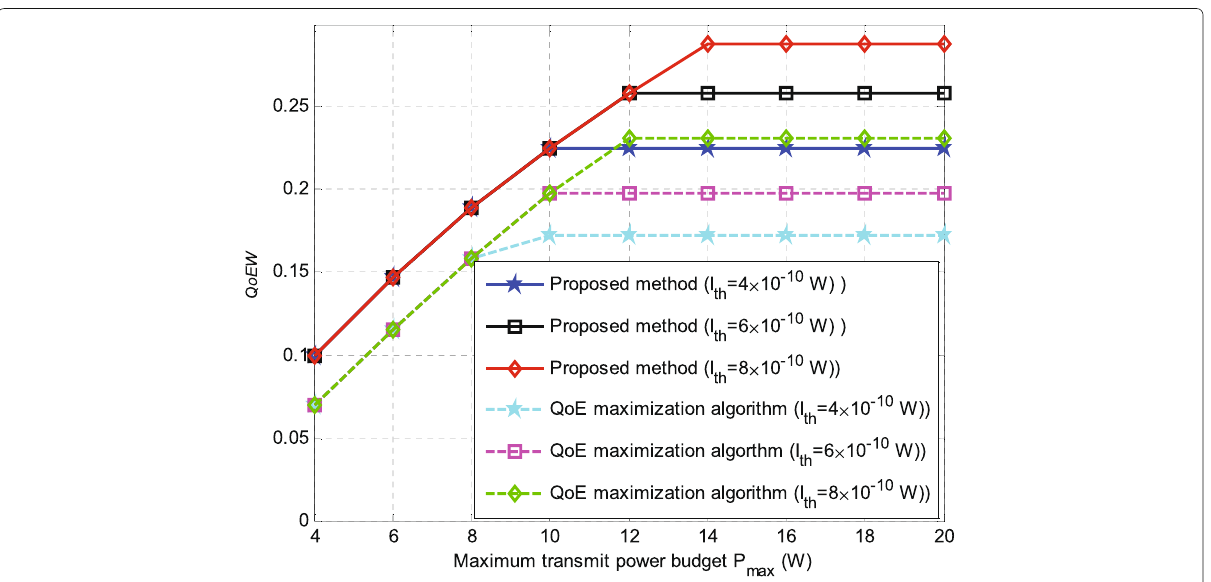
Fig. 7 QoEW versus the maximum transmit power budget